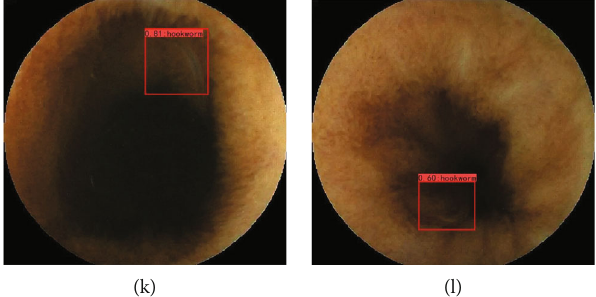
Figure 3: Representative images classi fi ed di ff erently by experts and the CNN in the validation set (green box, region identi fi ed as a hookworm by experts; red box, region identi fi ed as a hookworm by the convolutional neural network (CNN); number, the probability score of the CNN reading). Samples of false-negative images due to (a) bubble, (b) darkness, (c) debris, and (d) vascular shadow. Samples of false-positive images due to (e) fold, (f) fold, (g) debris, (h) bubble, (i) vascular shadow, and (j) darkness. (k, l) True hookworm detected by the CNN that were missed by the experts. Table 2: Causes of discrepancies in classi fi cations by the experts and by the CNN.